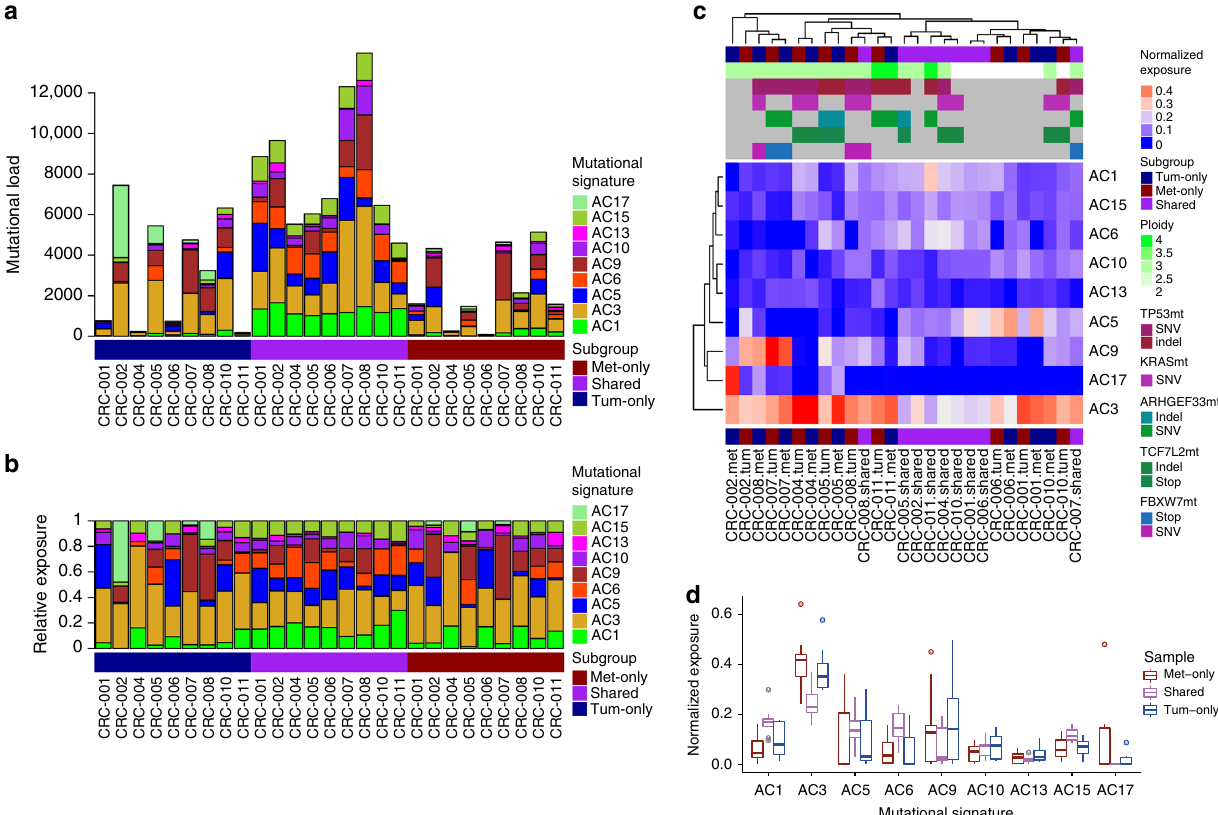
Fig. 6 Mutational signatures in colorectal cancer progression. Bar plot representation of absolute a , and normalized b COSMIC cancer mutational signatures within the strata of tumor-speci fi c (dark blue), metastasis-speci fi c (dark red) and shared (purple) somatic SNVs per patient with high tumor cell content (TCC). Unsupervised clustering of normalized exposures, with top annotation showing ploidy, estimated TCC and mutational status for TP53, KRAS, ARHGEF33, TCF7L2 , and FBXW7 c . Box and whisker plot of distributions of normalized exposures between mutations that are tumor-speci fi c (dark blue), metastasis-speci fi c (dark red), and shared (purple) per patient d . Boxes denote the interquartile range, the middle line denotes the median, and the vertical lines outside the box denote the minimal and maximum range excluding outliers (which are 1.5 times the interquartile